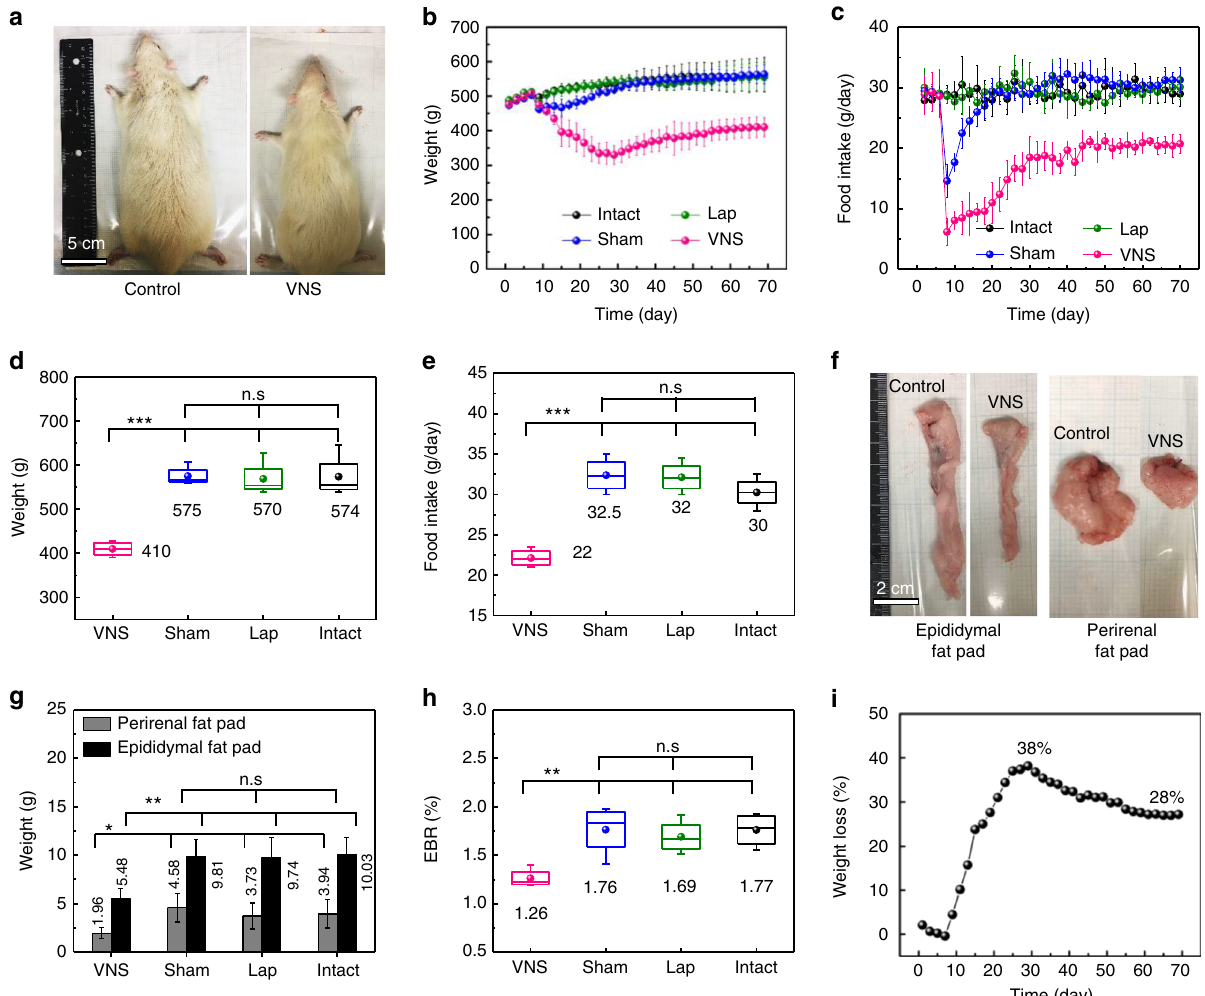
Fig. 5 Weight loss of fully grown adult rats after implantation of the VNS device. a Representative images of rats in the VNS group ( n = 4) and the control groups ( n = 4 for each control group). b Average body weight of rats in different groups over time (implantation was performed after 7 days of observation under normal conditions). c Rat ’ s food intake in different groups over time. d Final body weight of rats in different groups. e Final daily food intake in steady state of rats in different groups. f Representative images of white adipose tissue (epididymal fat pad and perirenal fat pad) of the VNS group and the control group (scale bar = 2 cm). g Adipose tissue weight of rats in different groups. h Epididymal fat pad/body weight ratio (EBR) of rats in different groups. i Percentage of weight loss over time after implantation of the VNS device. All data in b , c , and g are presented as mean ± s.d. In d , e , and h (box plots), dots are the mean, center lines are the median, box limits are the lower quartile (Q1) and upper quartile (Q3), and whiskers are the most extreme data points that are no more than 1.5× (Q3 – Q1) from the box limits. Statistical analysis was performed by two-tailed unpaired Student ’ s t tests. n.s., non-signi fi